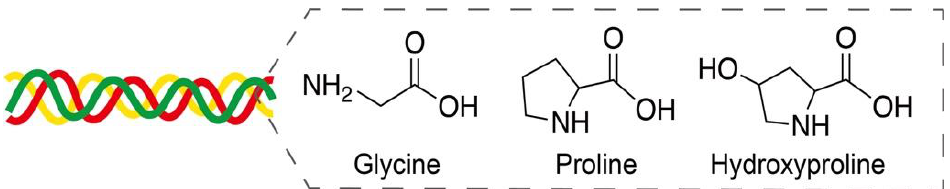
Figure 9 . Amino acids glycine, proline, and hydroxyproline in a triplex helix collagen structure. Adapted with permission from [73]; published by MDPI, 2020.